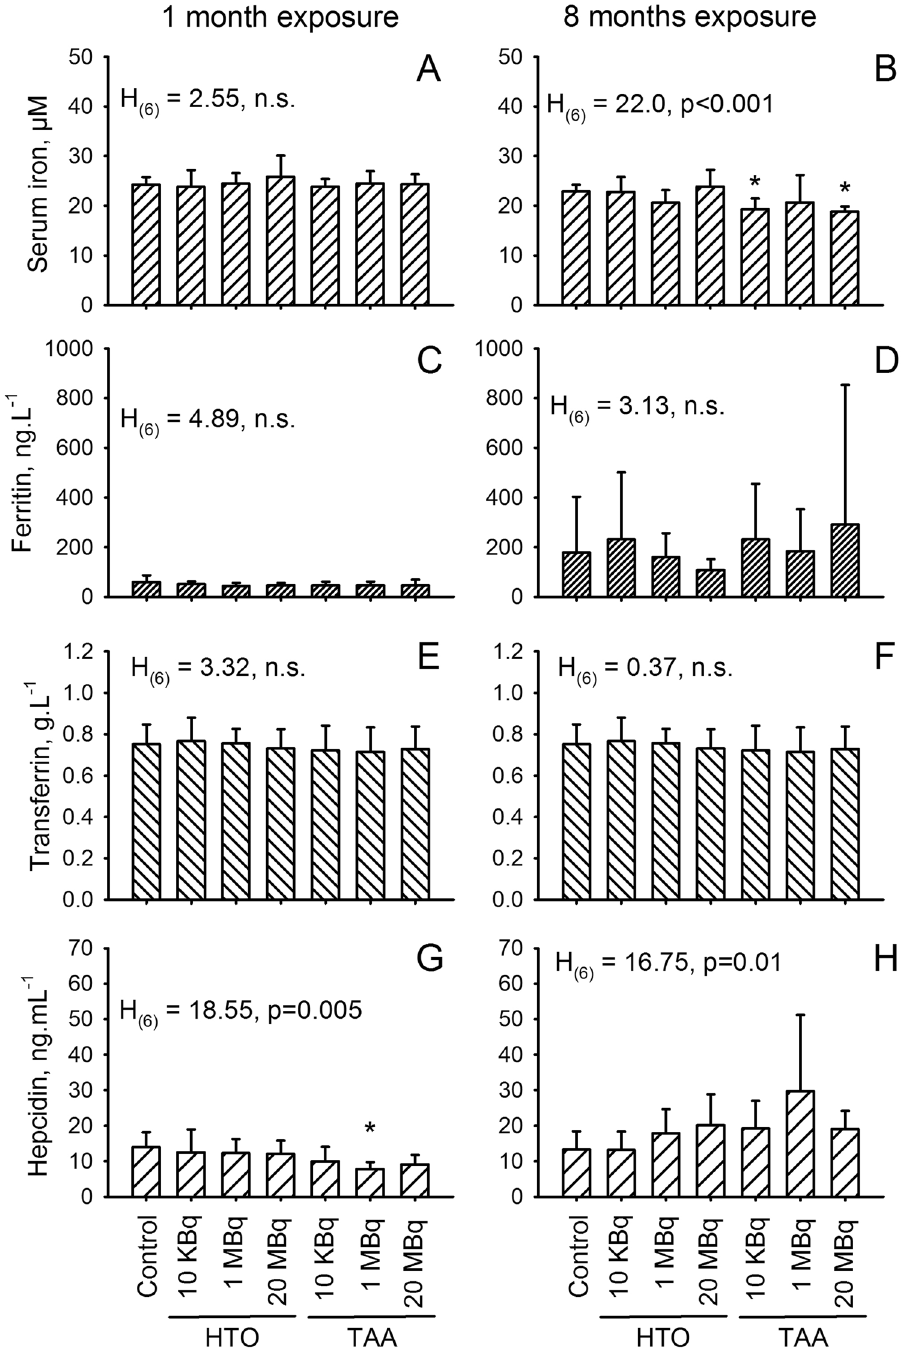
Figure 6. Plasma measurements of ( A , B ) serum iron; ( C , D ) ferritin; ( E , F ) transferrin and ( G , H ) hepcidin in animals exposed for one month ( A , C , E , G ) and for eight months ( B , D , F , H ). Results are presented as a mean ± SD of ten animals and results of the one-way anova analysis is indicated for each parameter and for each duration of exposure. A significant difference versus the control group was observed for * p < 0.05, using a multiple comparison procedure (Dum’s method). Since the control group served as the reference for the relative gene expression at each duration of exposure, it was not possible to compare data from the one-month exposure with data from eight-month